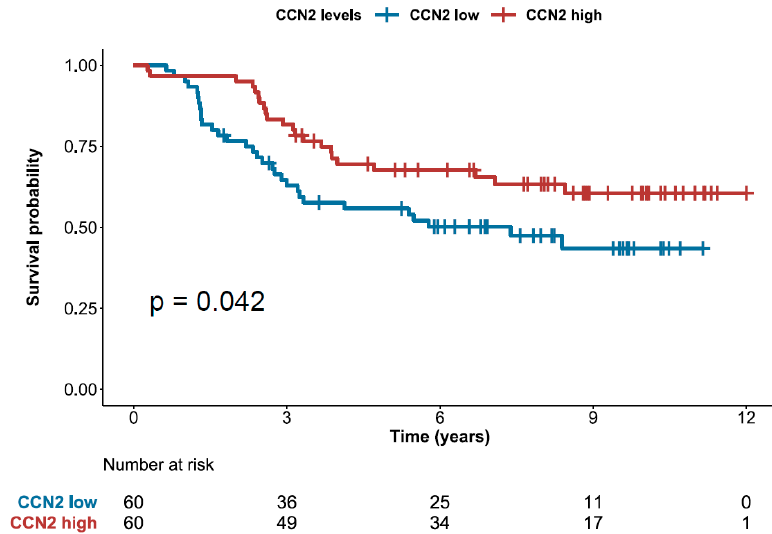
Figure 5. Kaplan-Meier overall survival curves of pediatric B-ALL patients divided in two groups according to whether CCN2 expression was above or beyond the median: “CCN2 high” and “CCN2 low”. The p -value of Cox univariate analyses is shown.